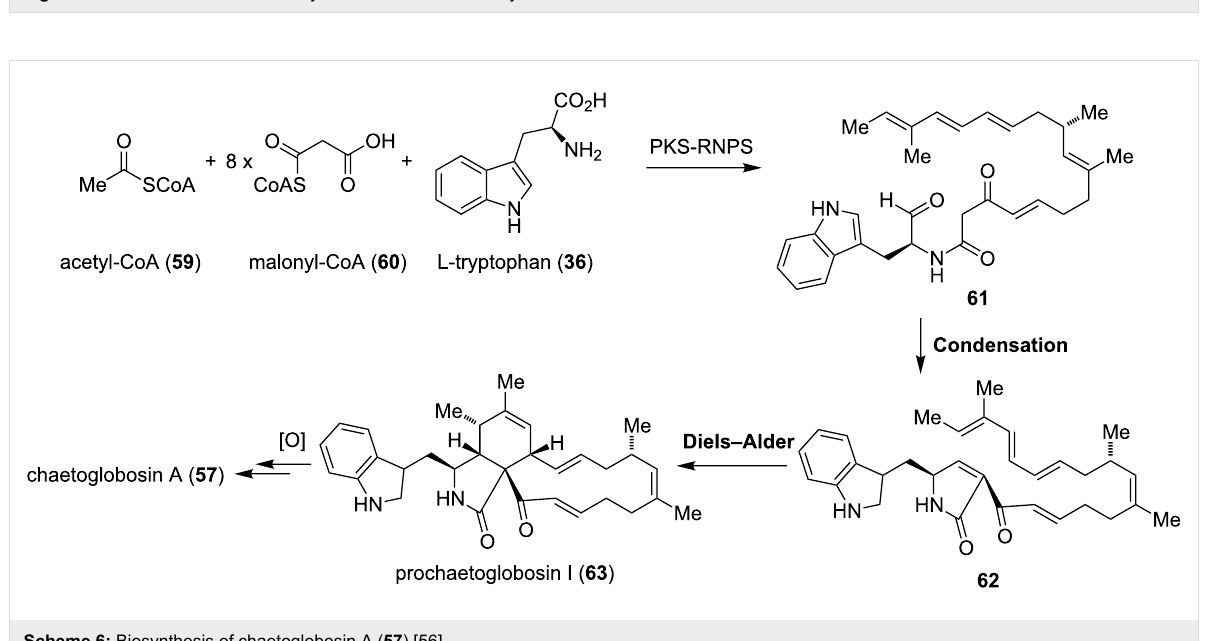
Figure 5: Selected members of the cytochalasan alkaloid family.